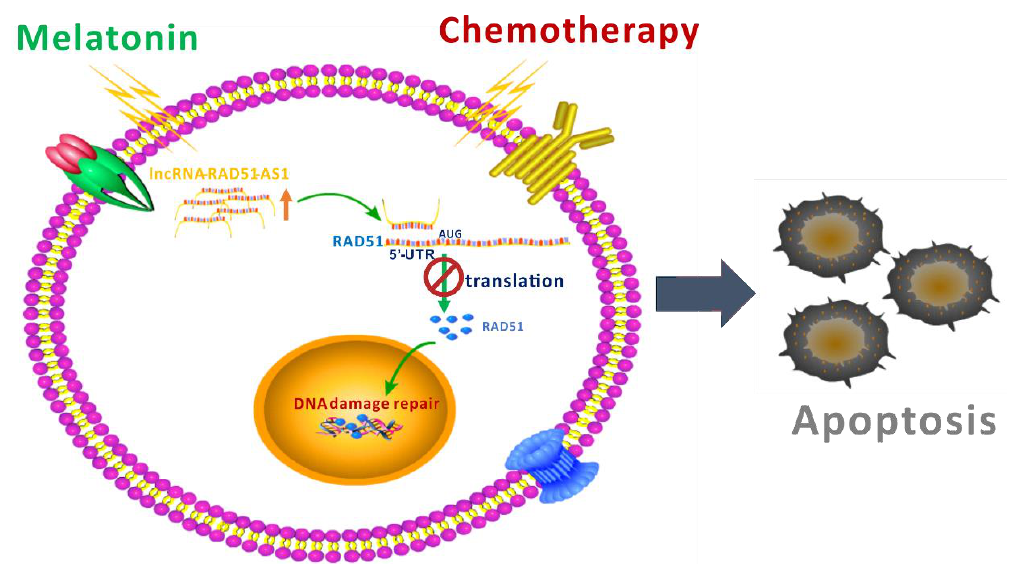
Figure 7. A schematic representation summarizing the mechanism by which melatonin suppresses DNA repair.